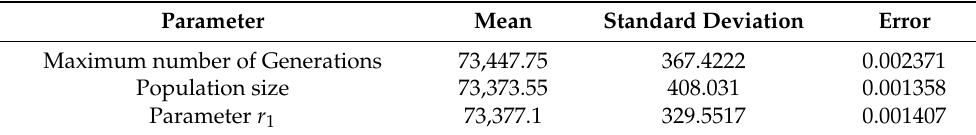
Table 9. The statistical measures and error for robustness analysis. Parameter Mean Standard Deviation Error Maximum number of Generations 73,447.75 367.4222 Population size